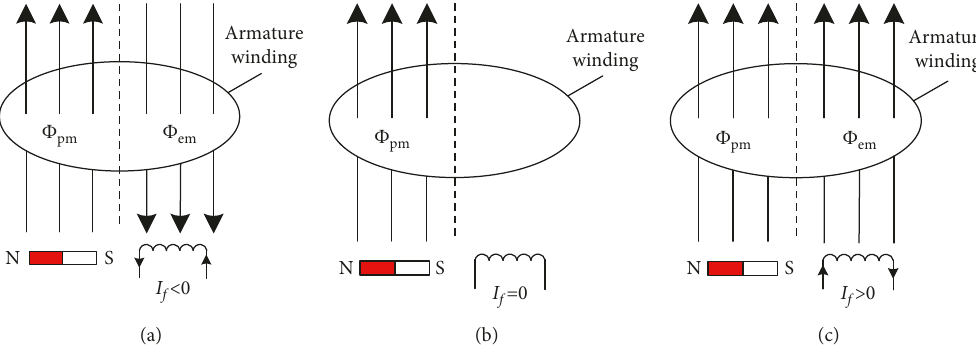
Figure 2: Schematic diagram of magnetic field regulation of HEG: (a) when the excitation current is less than 0A; (b) when the excitation current is equal to 0A; (c) when the excitation current is greater than